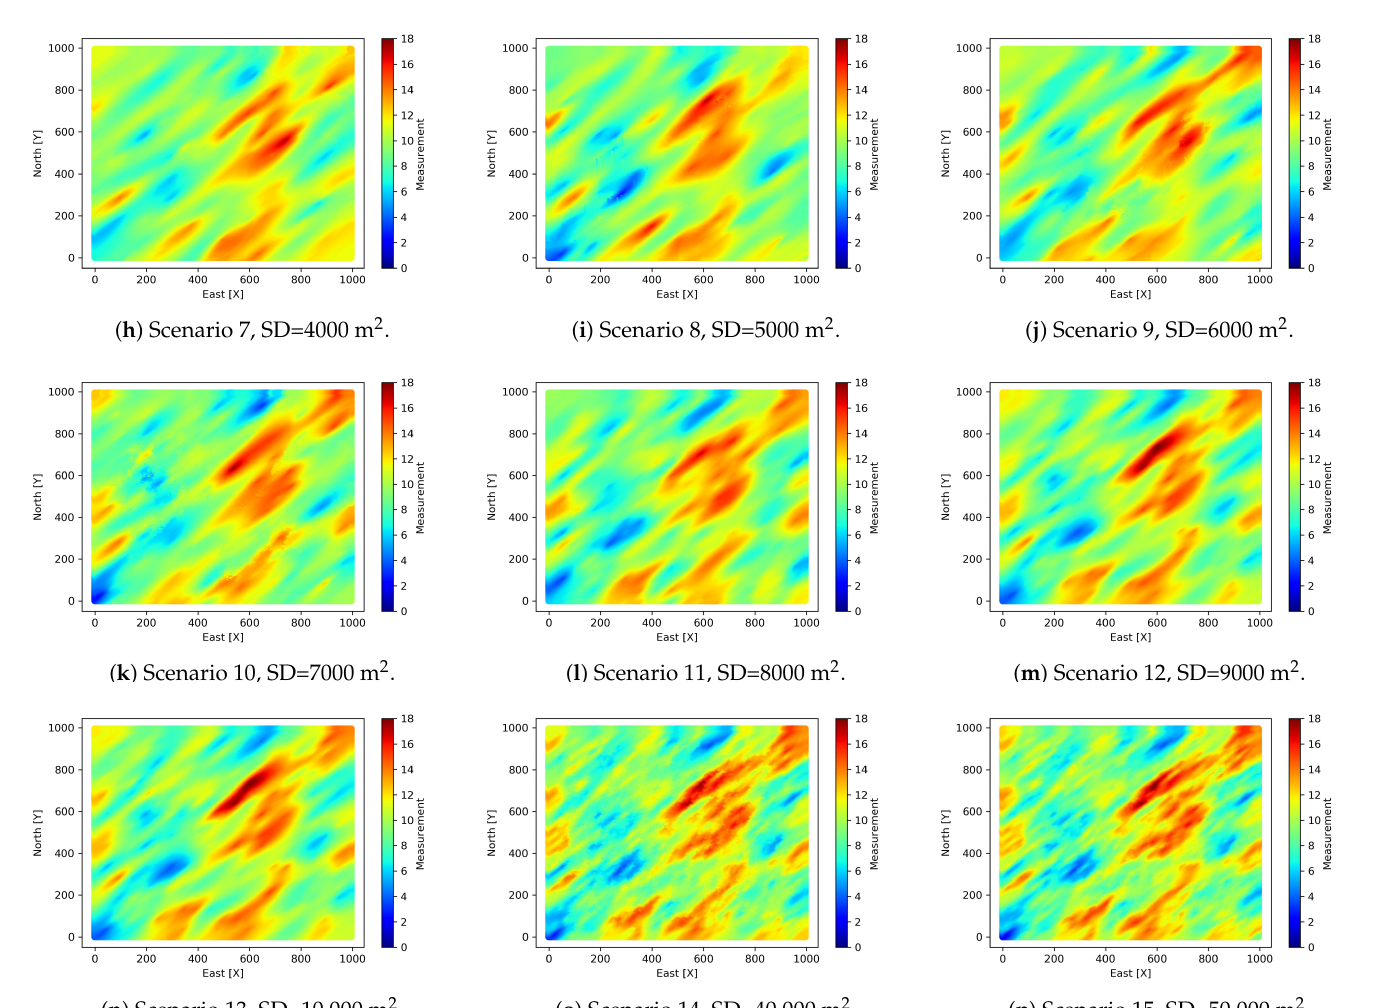
Figure 7. Coestimation maps versus simulated real Z 1